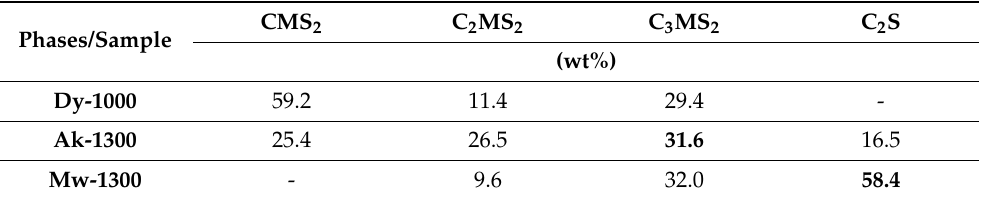
Table 1. Composition of the ceramics corresponding to diopside (Dy); akermanite (Ak); and merwi- nite (Mw) compositions, thermally treated at the highest temperature (1000 or 1300 ◦ C).